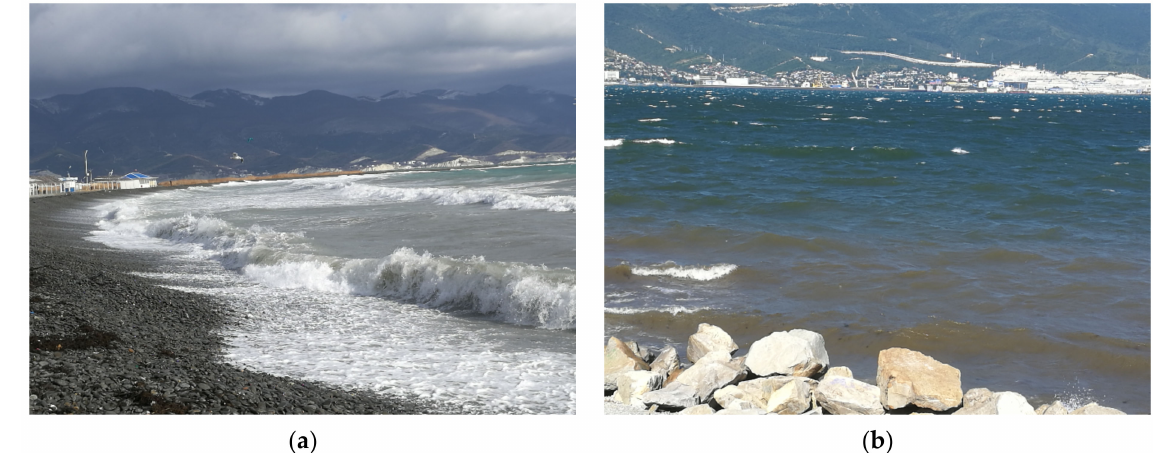
Figure 14. ( a ) Winter storm in Novorossiysk on 22 January 2021 caused by southerly winds; ( b ) summer storm in Novorossiysk on 9 July 2021 caused by northeasterly winds (Nord-Ost).